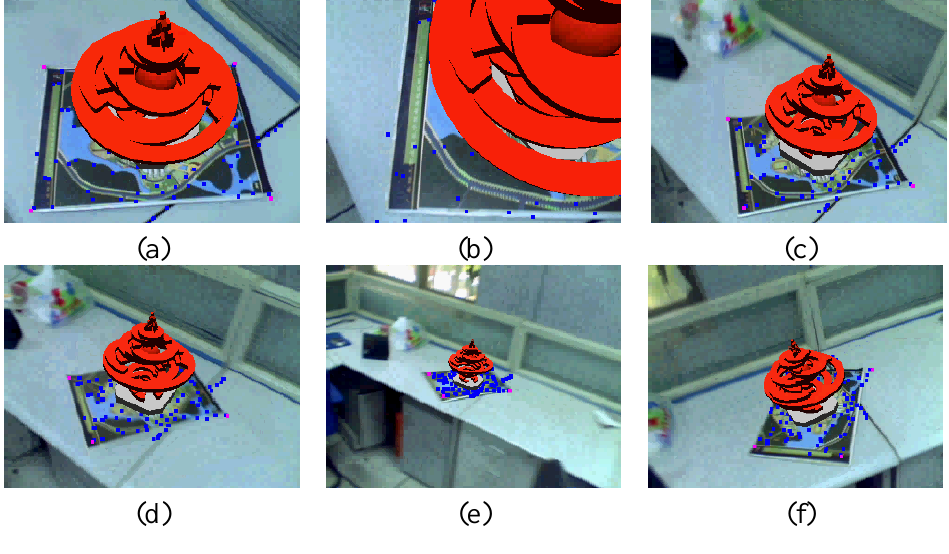
Figure 6. Results with planar